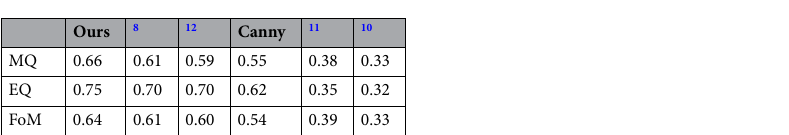
Figure 8. ( a ) Input image. ( b ) Ground Truth ( c ) Gaussian prefilter, (MQ, EQ, FoM) = (0.87, 0.84, 0.80). ( d ) Adaptive gaussian prefilter as prefilter, (MQ, EQ, FoM) = 0.86, 0.82, 0.78). ( e ) Median prefilter, (MQ, EQ, FoM) = (0.85, 0.85, 0.65).